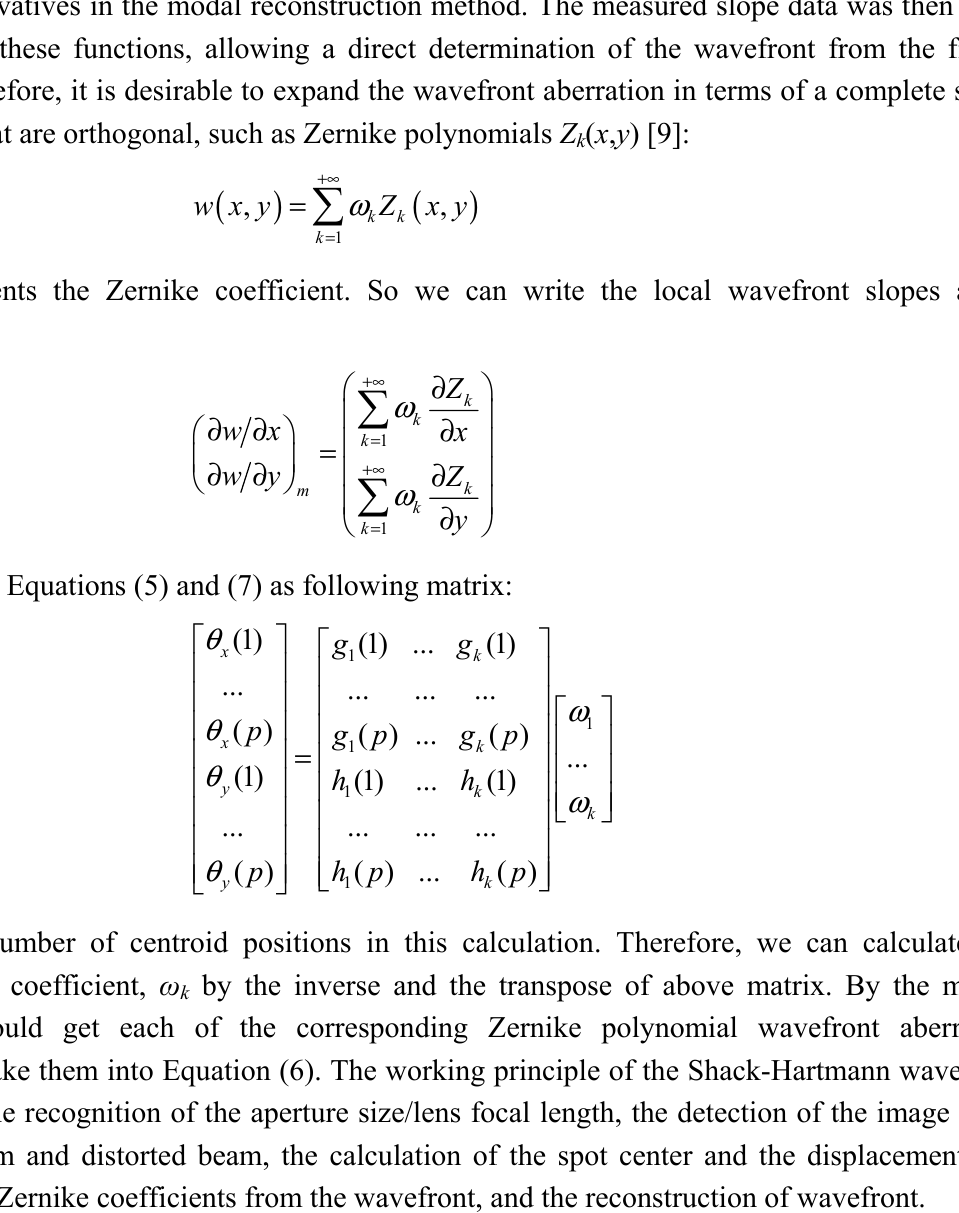
Figure 8. The laser light source from optical fiber is collimated by an aspherical lens screwed in